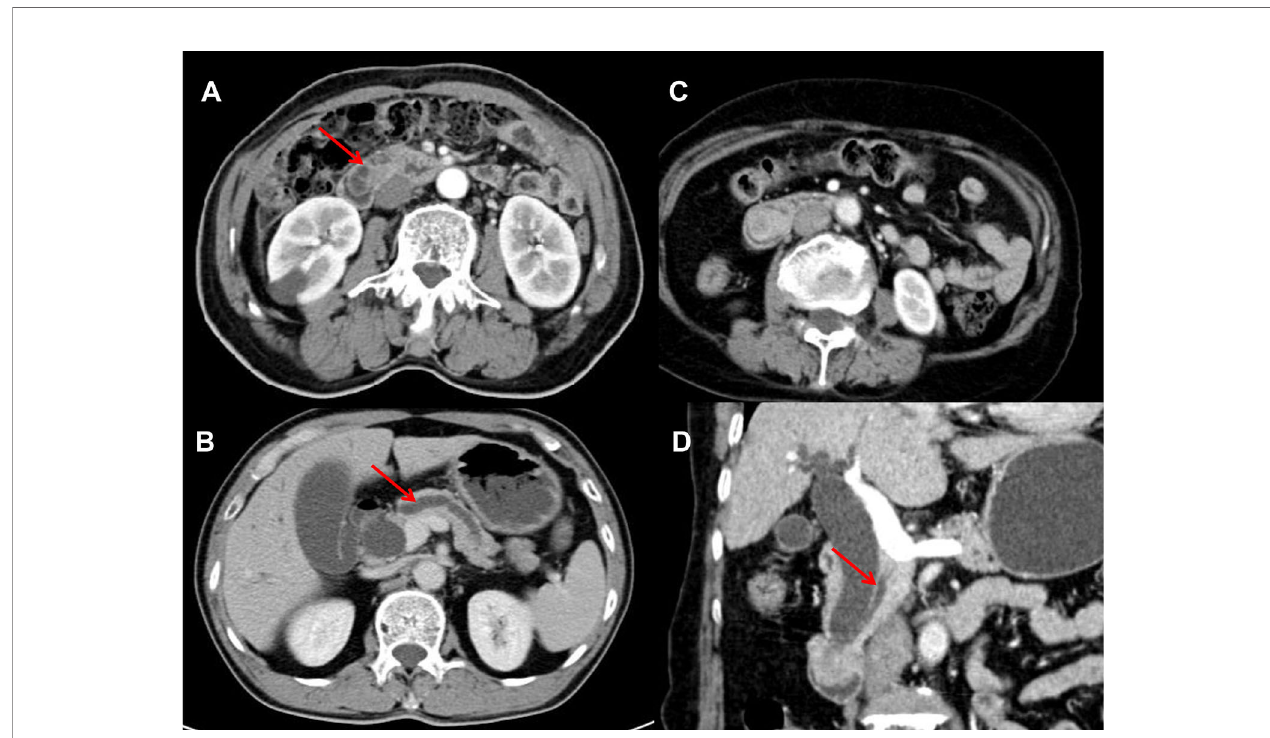
FIGURE 4 | Malignant enlargement of papilla in 66 and 67 years old male respectively, post-contrast image depicted dilation of PD >5 mm (7.4 and 7.8 mm respectively) (arrow) (A, B) ; Benign enlargement of papilla in a 75 years old female, the dilation of PD was 4 mm (<5 mm) (arrow) (C, D)